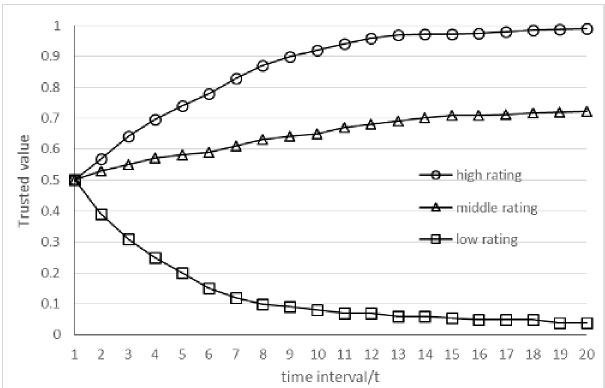
Fig. 1. The structure scheme of encryption system.